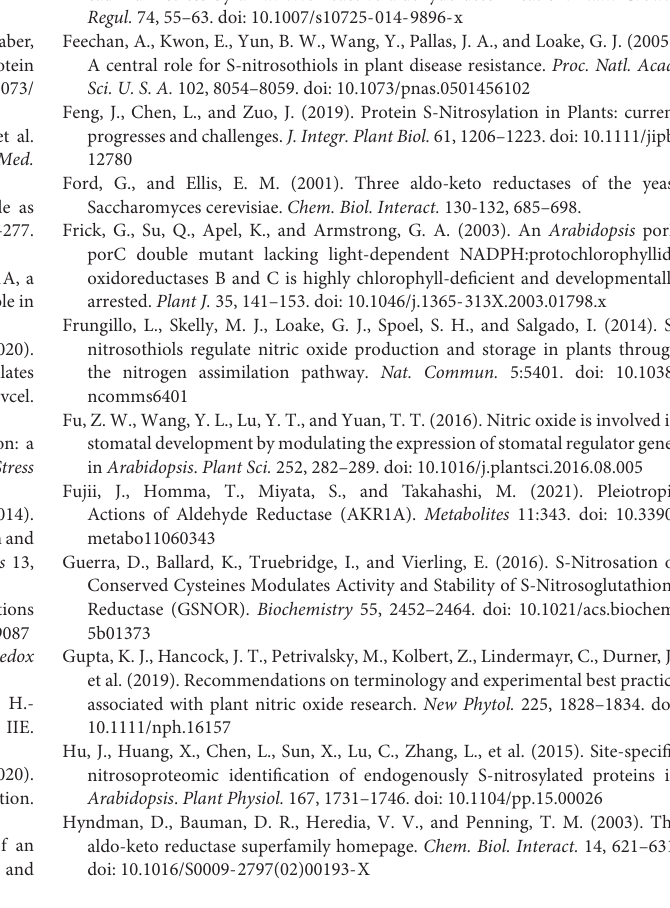
Supplementary Figure 1 | Proteomic sample analysis of WT and hot5-2 . (A) Soil grown (4- to 6-week-old) WT Col-0 and hot5-2 plants. Shoot material/leaves from five biological replicates per genotype were used in this study. (B) Number of identified proteins per sample after filtration in Perseus (see section “Materials and Methods”). (C) Global correlation analysis of identified proteins in WT and hot5-2 samples. Shown is a multi-scatter plot with Pearson correlation coefficient values indicated at the top of each sector; correlation coefficients between replicates of either genotype were 0.98–0.99, while for comparisons between genotypes the coefficients are 0.96–0.97. (D) Principal component analysis (PCA) plot of differentially expressed proteins indicates differences between WT and hot5-2 samples. Supplementary Figure 2 | Purified AKR4C proteins. Coomassie blue staining of purified AKR4C8, AKR4C9, AKR4C10, and AKR4C11 proteins, treated with ( + ) or without ( − ) the reducing agent β -mercaptoethanol [2.5% (v/v)]. Three micrograms of each protein were loaded onto 12% SDS-PAGE gels to assess purity of the recombinant proteins. MW markers are shown at the left. Supplementary Figure 3 | Cross reactivity of AKR4C polyclonal rabbit antibodies. Purified AKR4C proteins (25 ng) were separated by 12% SDS-PAGE and subjected to immunoblotting using polyclonal antibodies raised against each protein as mentioned in section “Materials and Methods.” Theoretical molecular masses of non-tagged proteins are 34.69 kDa for AKR4C8, 35.13 kDa for AKR4C9, 34.91 kDa for AKR4C10, and 35.03 kDa for AKR4C11. Supplementary Figure 4 | Comparison of human AKR1A1 and A. thaliana AKR4C proteins. Multiple sequence alignment of human AKR1A1 (Uniprot identifier P14550-1) and A. thaliana AKR4C (AT2G37760.2, AKR4C8; AT2G37770.2, AKR4C9; AT2G37790.1, AKR4C10; and AT3G53880.1,